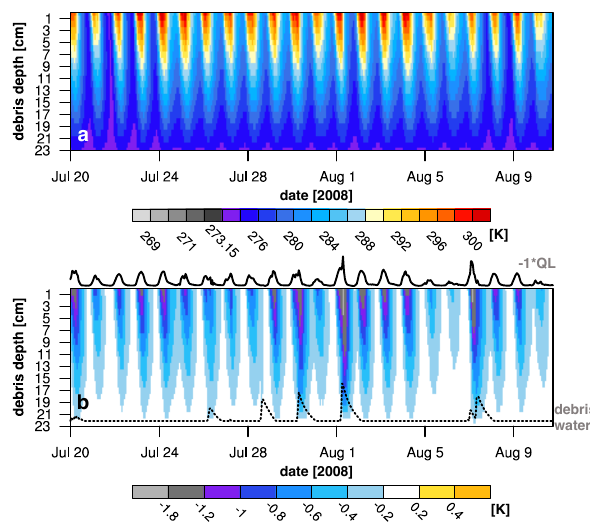
Fig. 9. Temporal and depth variation of (a) CMB-RES debris tem- Figure 9. Temporal and depth variation of (a) CMB-RES debris peratureand (b) thedifferencebetweenthemodelruns(CMB-RES temperature and (b) the difference between the model runs (CMB- minusCMB-DRY).Unitsare K .Forreference,-1 ∗ QL(solid-black curve;nowpositiveforenergylossfromthesurface)anddebriswa- RES minus CMB-DRY). Units are in kelvin (K). For reference, - ter content (black dashed) are plotted without y-axes in panel (b) . 1 ∗ QL (solid-black curve; now positive for energy loss from the sur- The height of the debris-water curve shows the estimated level of moistureinthereservoir. face) and debris-water content (black dashed) are plotted without y axes in panel (b) . The height of the debris-water curve shows the estimated level of moisture in the reservoir.